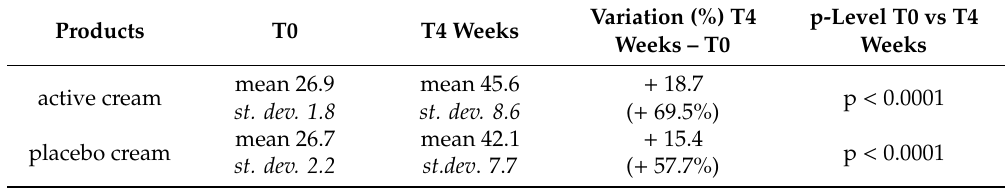
Table 6. Mean values of skin hydration recorded for active cream and placebo product (t-test).